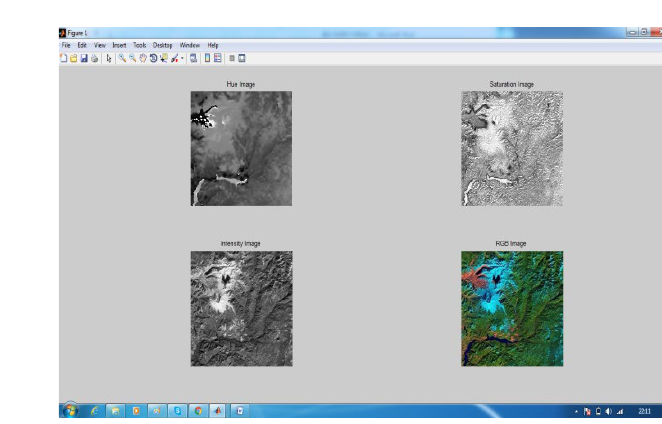
Figure 12. Satellite picture - 2